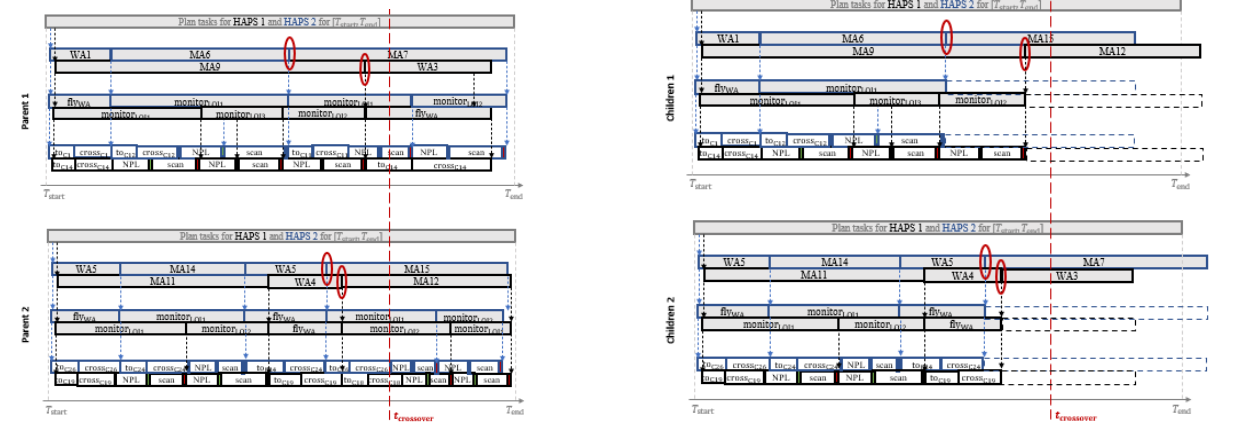
Figure 6. Single-point crossover with a random selection of the temporal crossover